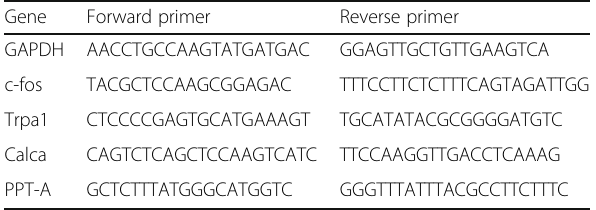
Table 2 Sequences of primers used Gene Forward